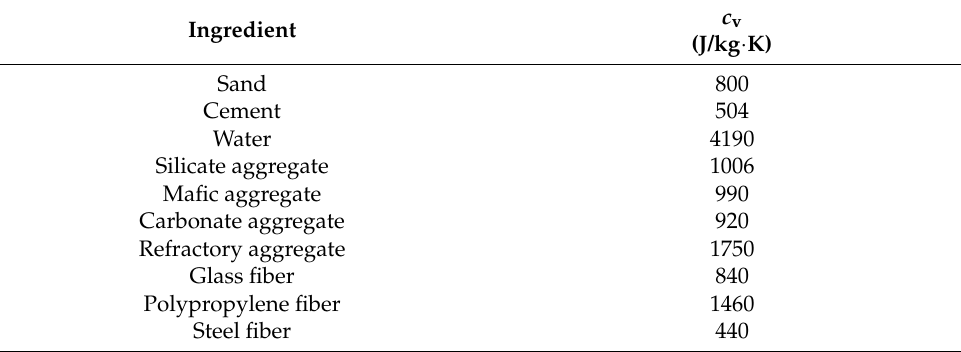
Table 4. Specific heat of raw materials used to prepare samples.